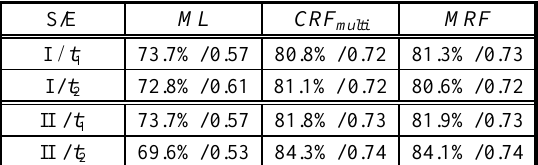
Table 2: Overall classification accuracy / kappa coefficients; S/ E: Set-up/epoch; set up I: t 1 : Ikonos, 2005; t 2 : Ikonos, 2007; set up II. t 1 : Ikonos, 2005; t 2 : Landsat, 2010.